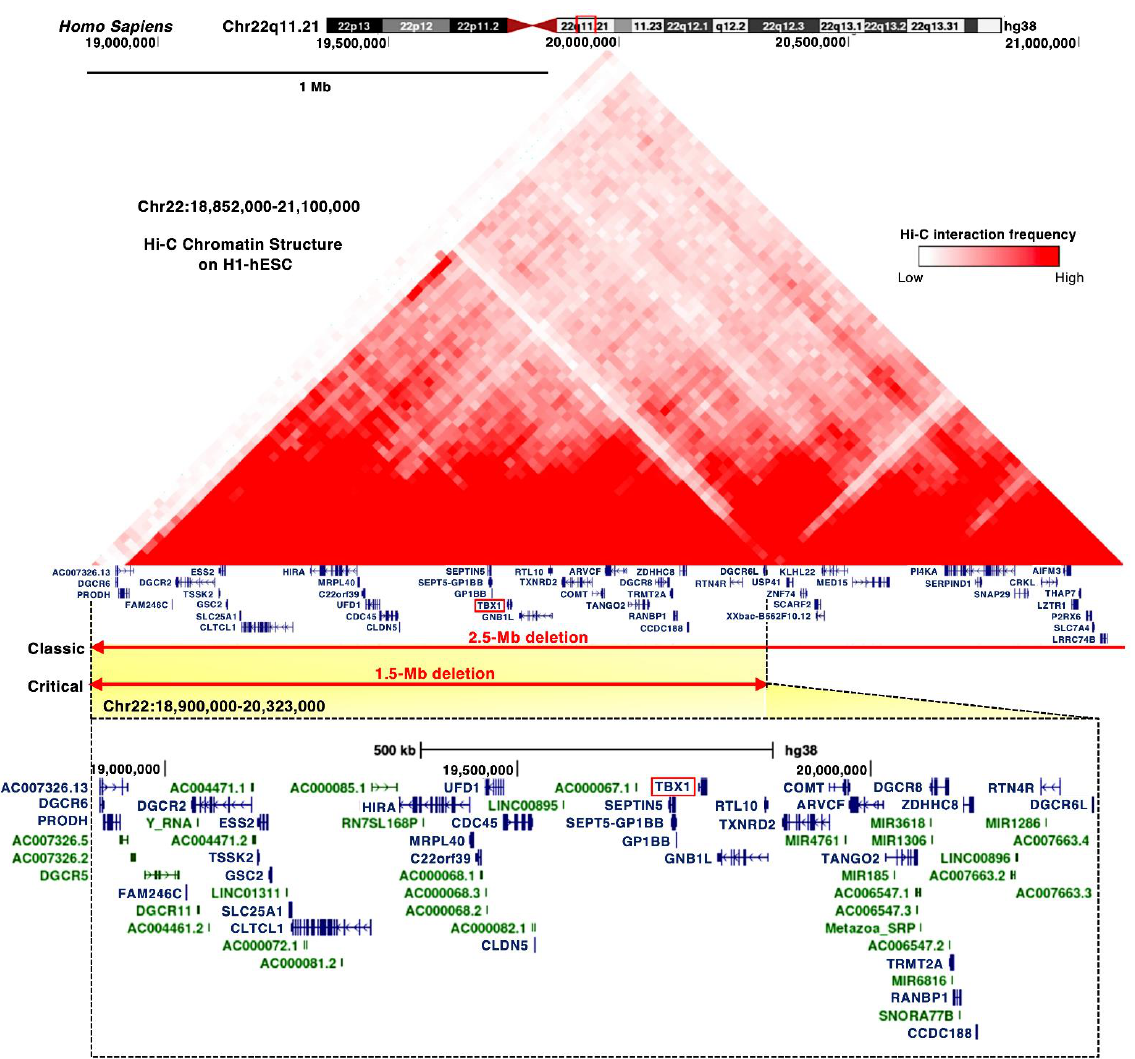
Figure 1. Proximal deletions of chromosome 22q11.2 are responsible for the clinical features of DGS/VCFS. Snapshot of the UCSC Genome Browser (http://genome.ucsc.edu accessed on 3 August 2021) in the hg38 assembly showing the genomic context in the proximal deletions of chromosome 22q11.2. Top, the 25 kb resolution Hi-C data in H1 human embryonic stem cell line (H1-hESC). Bottom, the coding (blue) and noncoding RNAs (green), including miRNAs and long noncoding RNAs, are shown. Table 3. DGS/VCFS-associated variants of TBX1.